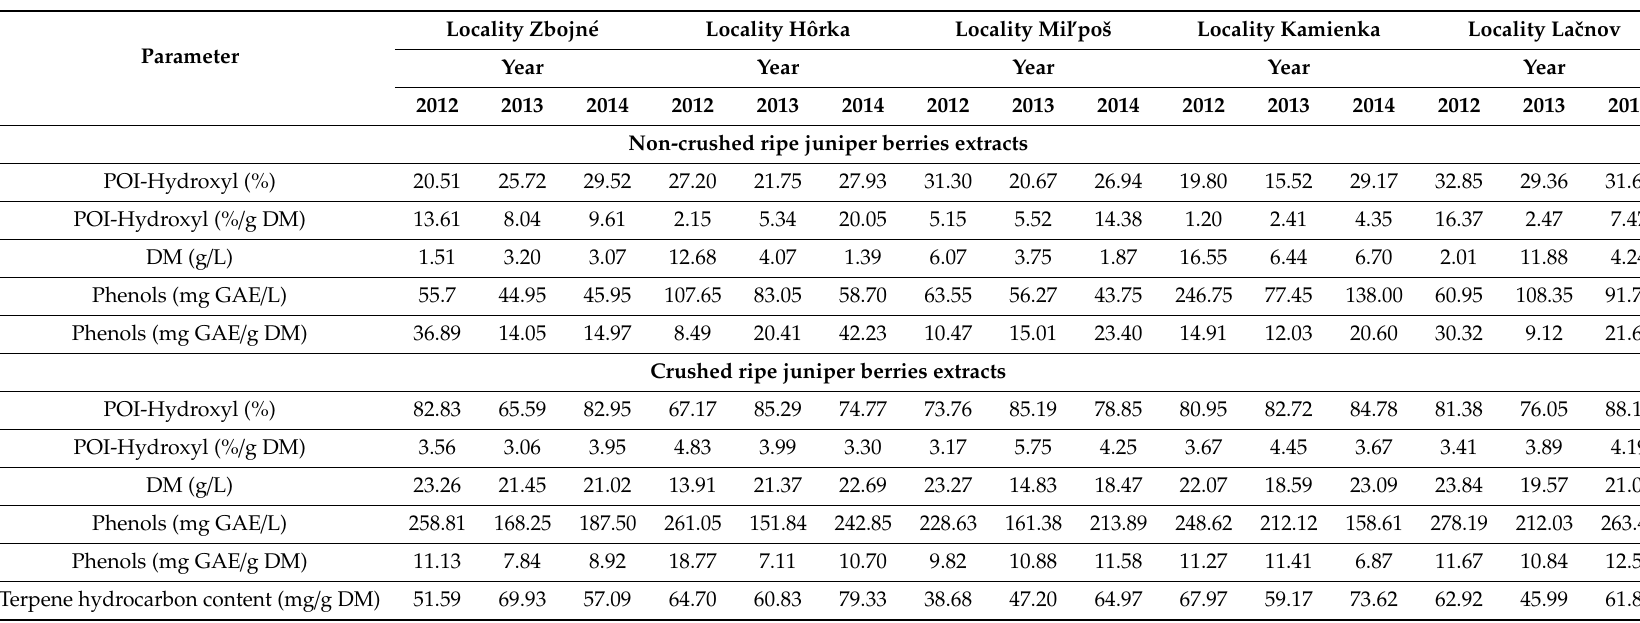
Table 1. Antioxidant activity against hydroxyl radicals, dry matter, total phenols and contents of essential oil components in 70% ethanol extracts of juniper berries.